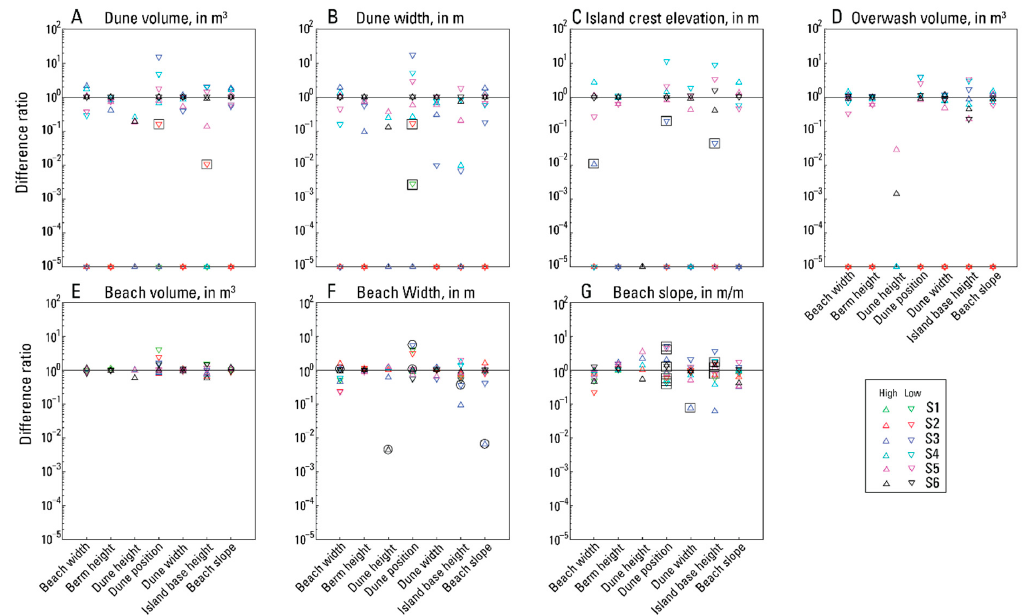
Figure 13. 2D difference ratio of percent change of alongshore averaged dune volume ( A ), dune width ( B ), island crest elevation ( C ), overwash volume ( D ), beach volume ( E ), beach width ( F ), and beach slope ( G ) of the baseline and modified profiles; note circled markers around storm markers (S1–S6) indicate a negative relative response difference. Black squares indicate the pre- to post-storm difference in the baseline simulation was 0 or positive and black circles indicate the pre- to post-storm difference in the baseline simulation was negative. Horizontal black line indicates a difference ratio of 1; undefined or 0 ratio values were set to 10 − 5 for inclusion in the figures.